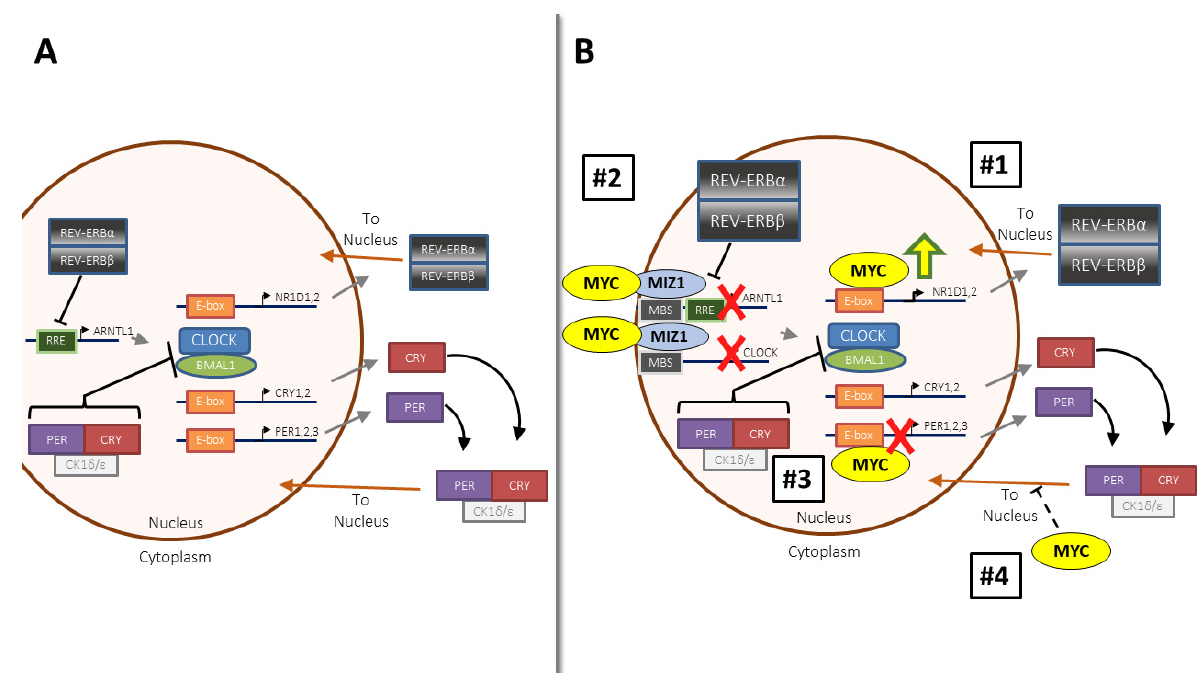
Figure 1. MYC disrupts the molecular circadian clock through different mechanisms. ( A ). Model and schematic of the molecular clock in mammalian cells. The two principal feedback loops governing rhythmicity are shown. Briefly, PER and CRY govern CLOCK-BMAL1 or NPAS2-BMAL1 activity, while REV-ERB α and REV-ERB β suppress BMAL1 ( ARNTL ) transcription. The ROR (RAR-related orphan receptor) family of transcription factors positively control BMAL1 transcription (not shown). ( B) . Four mechanisms of MYC-induced disruption of the molecular clock. #1: MYC upregulates REV-ERB α and β , which suppress BMAL1 transcription. #2: MYC binds to the transcription factor MIZ1 and inhibits it, leading to suppression of CLOCK and BMAL1 transcription. #3: MYC occupies the promoters of molecular clock genes such as the PER genes and suppresses their transcrip- tion. #4: MYC interferes with the nuclear–cytoplasmic shuttling of the PER proteins. In each panel, grey arrows indicate expres- sion of gene and translation to protein, orange arrows indicate translocation of protein to nucleus, black arrows indicate CRY and PER forming a complex, black suppression arrows indicate repression of target process by proteins (i.e., REV-ERB α and REV-ERB β repress transcription of ARNTL1 ), black suppression arrows with dotted line indicate that the mechanism of MYC repression of PER translocation to the nucleus is not well defined, green and yellow up arrow indicates that MYC induces ex- pression of gene, and red X marks indicate that expression of gene is suppressed or abolished. Abbreviations: RRE: ROR/REV- ERB response element; MBS: MIZ1 binding site; CK1: casein kinase 1. Figure is adapted and modified, with permission under CCBY 4.0, from a previous publication [22] .